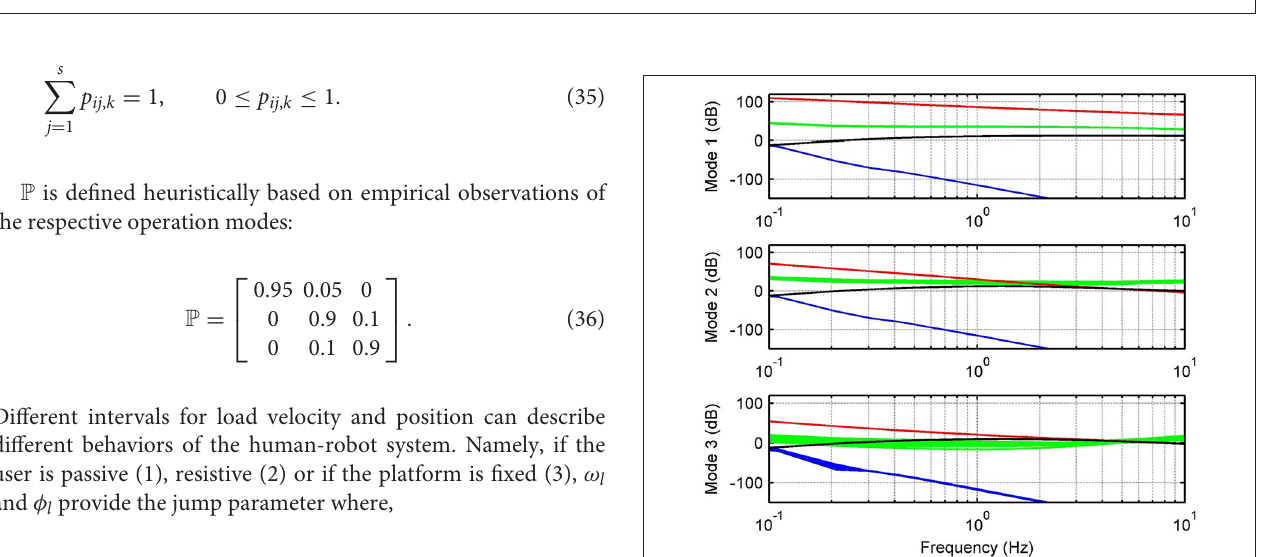
FIGURE 4 | Force control approaches. (A) Recursive Robust Regulator for DMJLS: the block “Platform + Human” corresponds to the state variable model in are the control gains. (B) H ∞ control configuration of the system: G n is the process plant, P is the augmented plant including the Equation 20, K int , θ and K a , θ k k weight functions and K c is the controller.